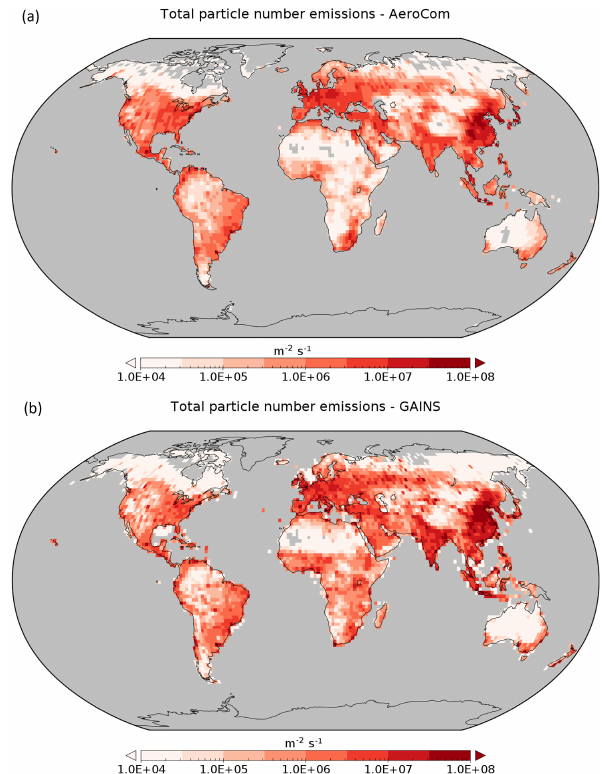
Figure 3. Total absolute anthropogenic emissions for (a) AeroCom and (b) GAINS without visual